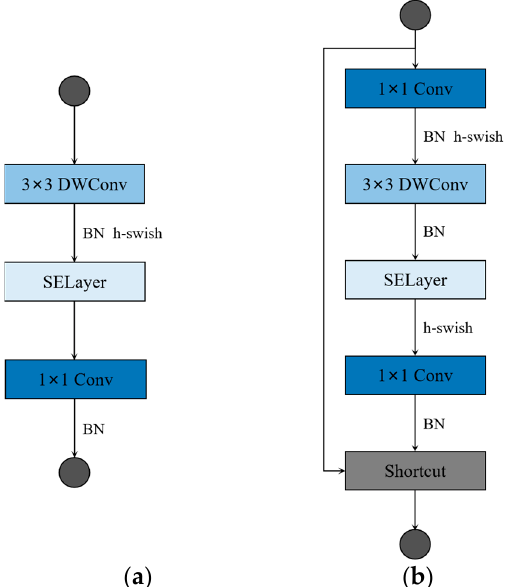
Figure 1. Building blocks of MobileNetv3. ( a ) No channel expansion units; ( b ) the unit of channel expansion with residual connection (when stride is set to one, and in_channels are equal to out_channels). DWconv denotes depthwise convolution.